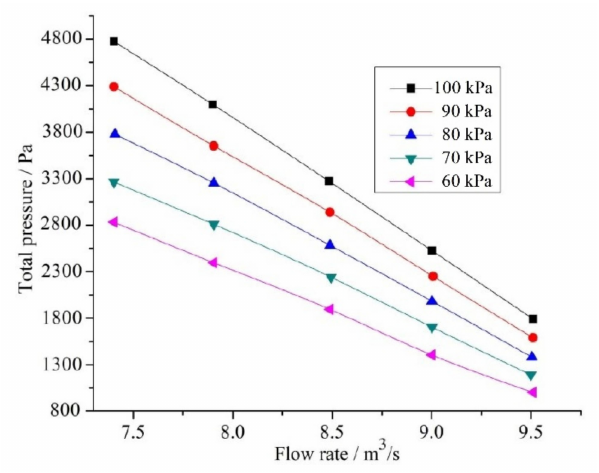
Figure 7. Total pressure of the fan under di ff erent ambient pressures.